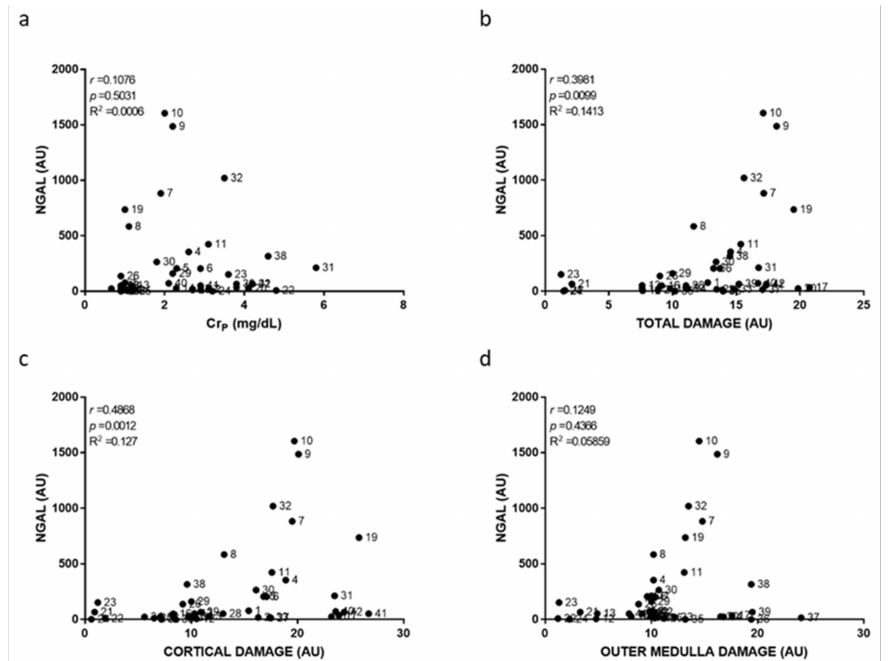
Figure 4. Urinary NGAL to plasma creatinine and to renal damage relationships. Scatter plots showing the relationship between urinary NGAL levels and plasma creatinine concentration (Cr p ) ( a ), overall renal tissue damage ( b ), renal cortical damage ( c ), and outer medullary damage ( d ) of individual rats. AU, arbitrary units. p , Spearman’s correlation p -value. r , Spearman’s correlation coefficient. R 2 , linear regression coefficient of determination.